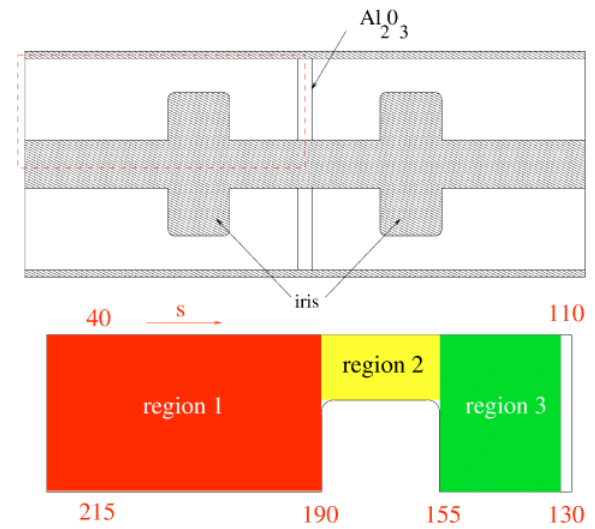
FIG. 6. (Color) Profile of the iris-type TW window, with curvi- linear abscissa (cid:1) s (cid:2) reference.